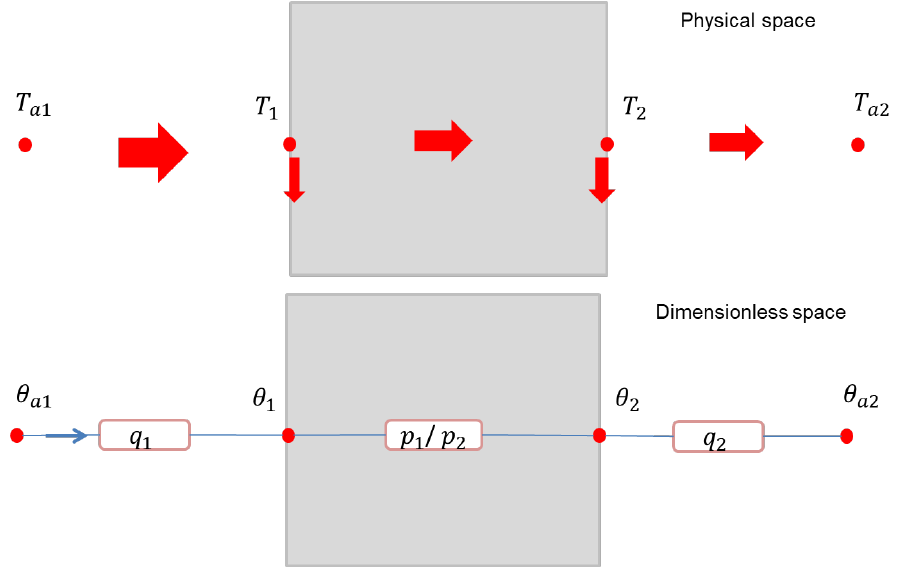
Figure 5. Simplified schematic for the thermal behavior in Physical space vs. Dimensionless space.